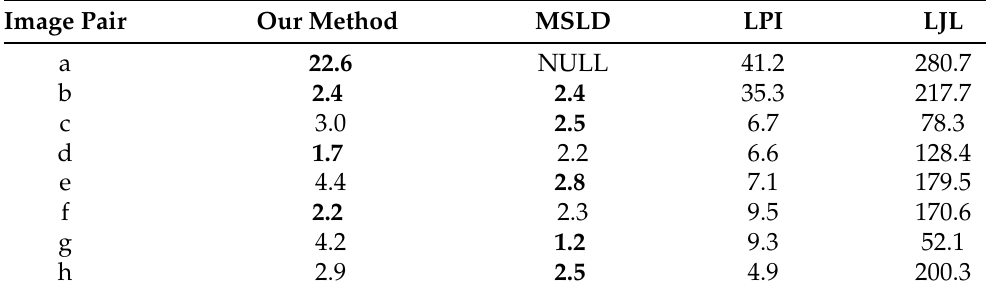
Table 3. Real-time performance